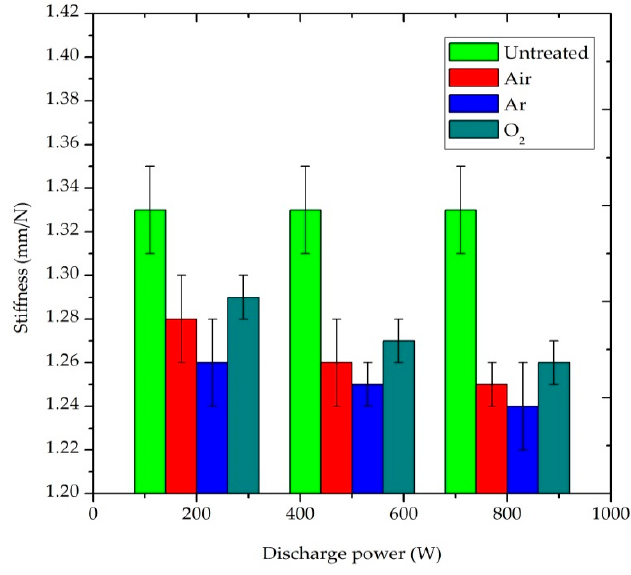
Figure 6. Effect of plasma treatment on the stiffness property of P/C blend fabric. Figure 6. E ff ect of plasma treatment on the sti ff ness property of P / C blend